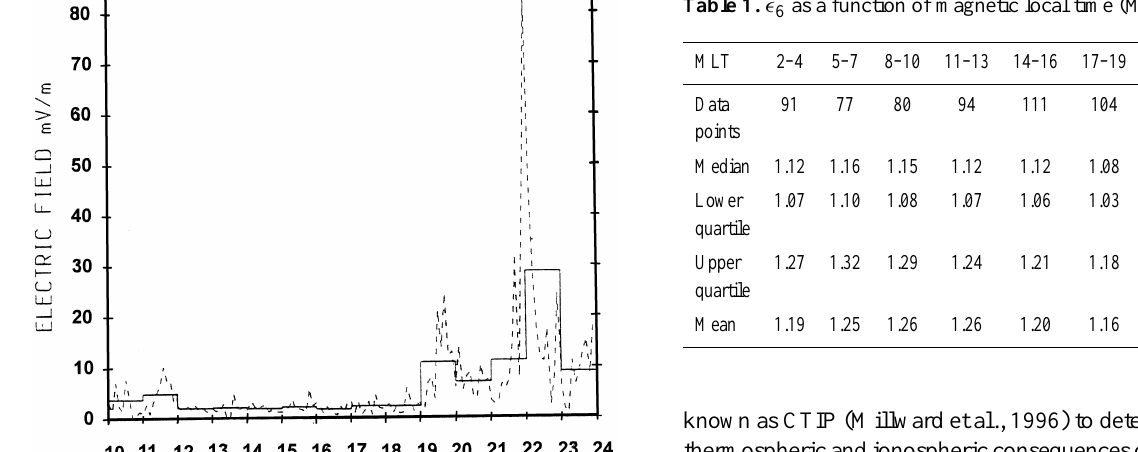
Table 1. (cid:15) 6 as a function of magnetic local time